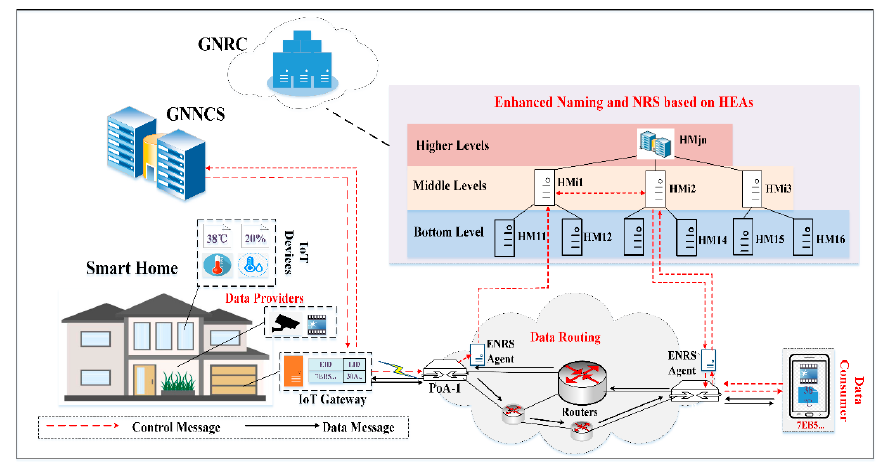
Figure 5. The use case scenario of ENRS.